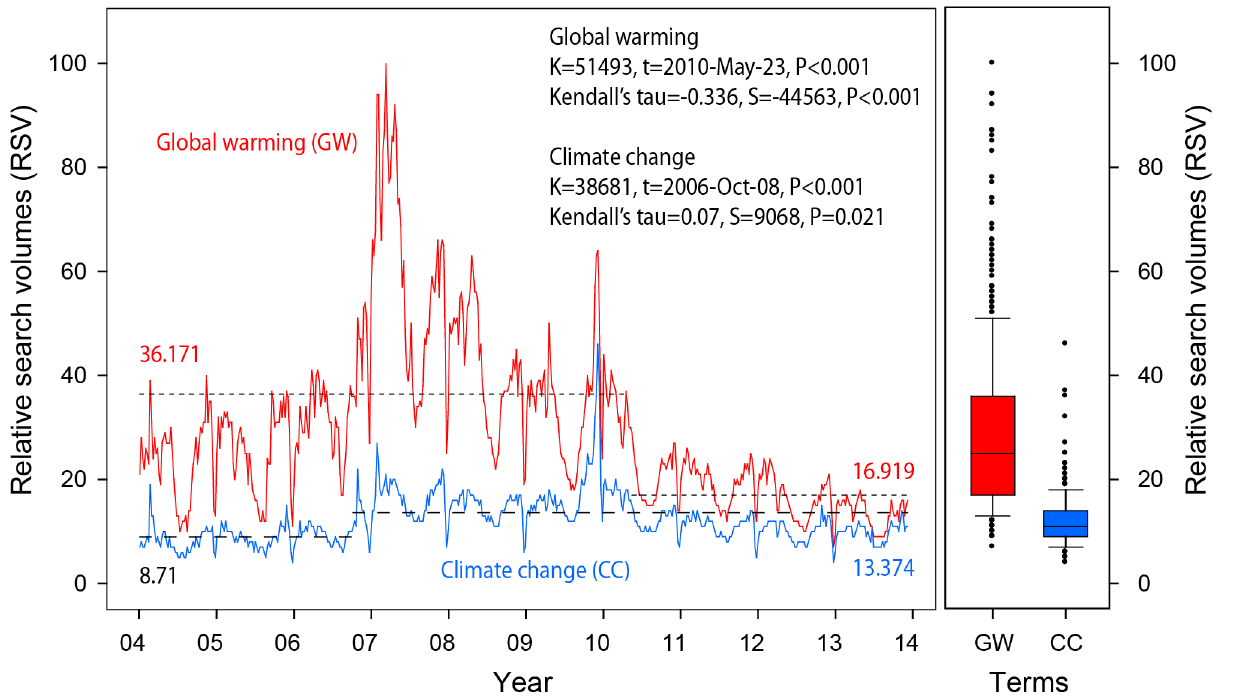
Fig 1. Change in relative search volume (RSV) for “ global warming ” and “ climate change ” as search terms (2007 – 2013); dash line represents the mean for the RSV for each